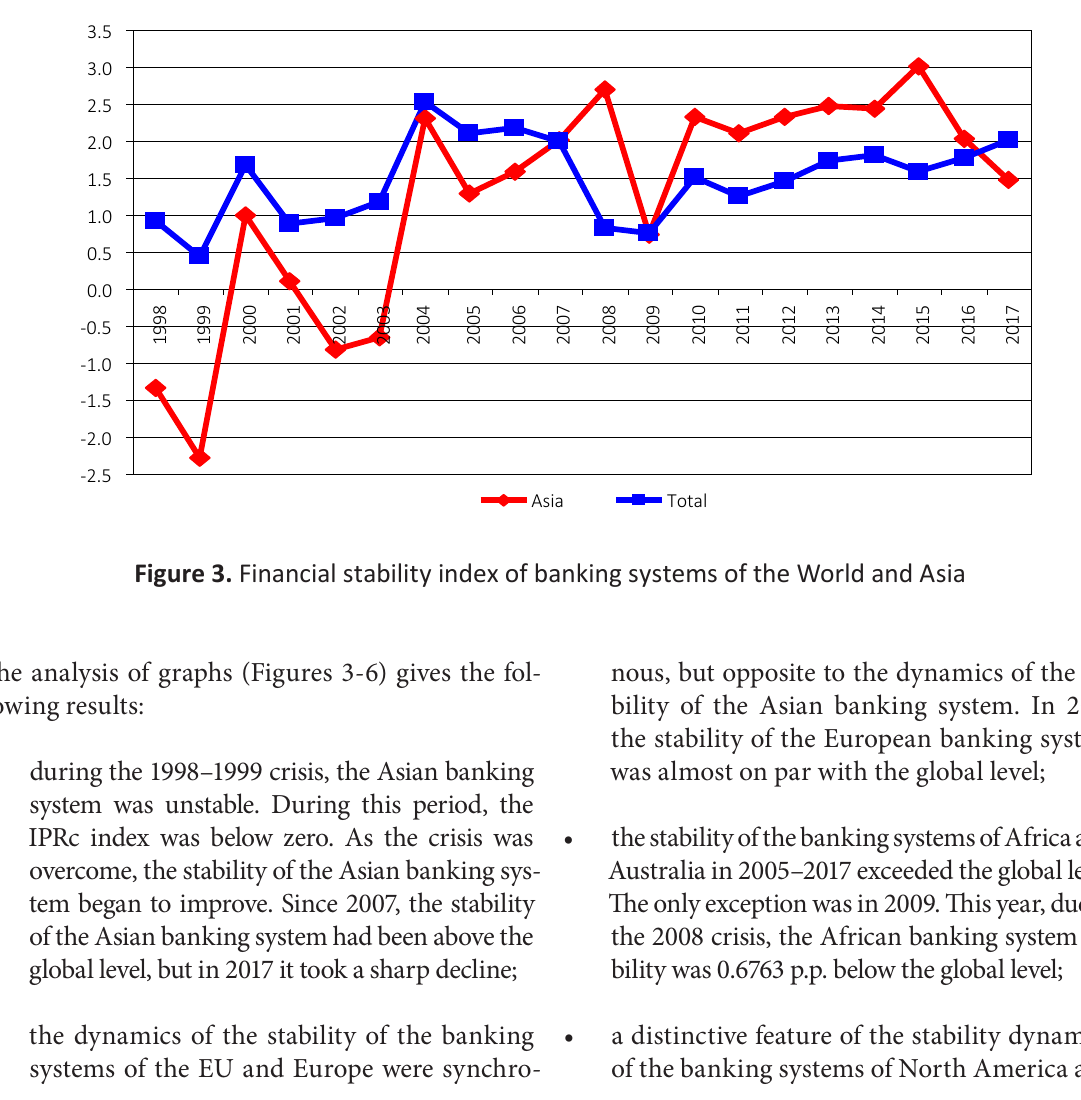
Figure 2. Percentage of countries in the risk zone and percentage of banking assets in the risk zone